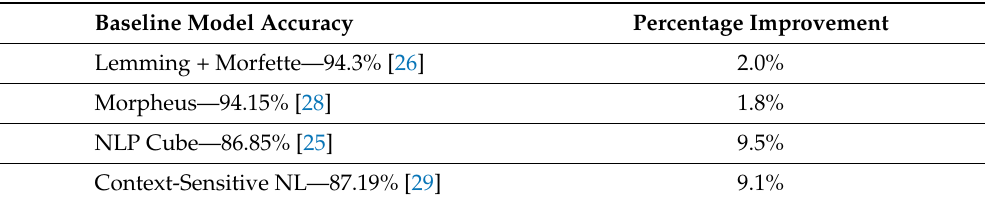
Table 9. Comparison of cosine similarities of the proposed model with baseline